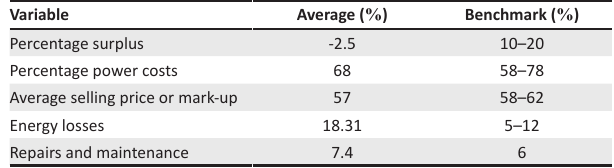
TABLE 7: Financial performance indicators (2016/2017).